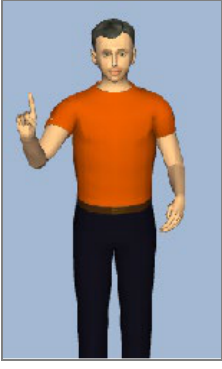
Figure. 3(a). Startup page of Punjabi to Sign language translation system